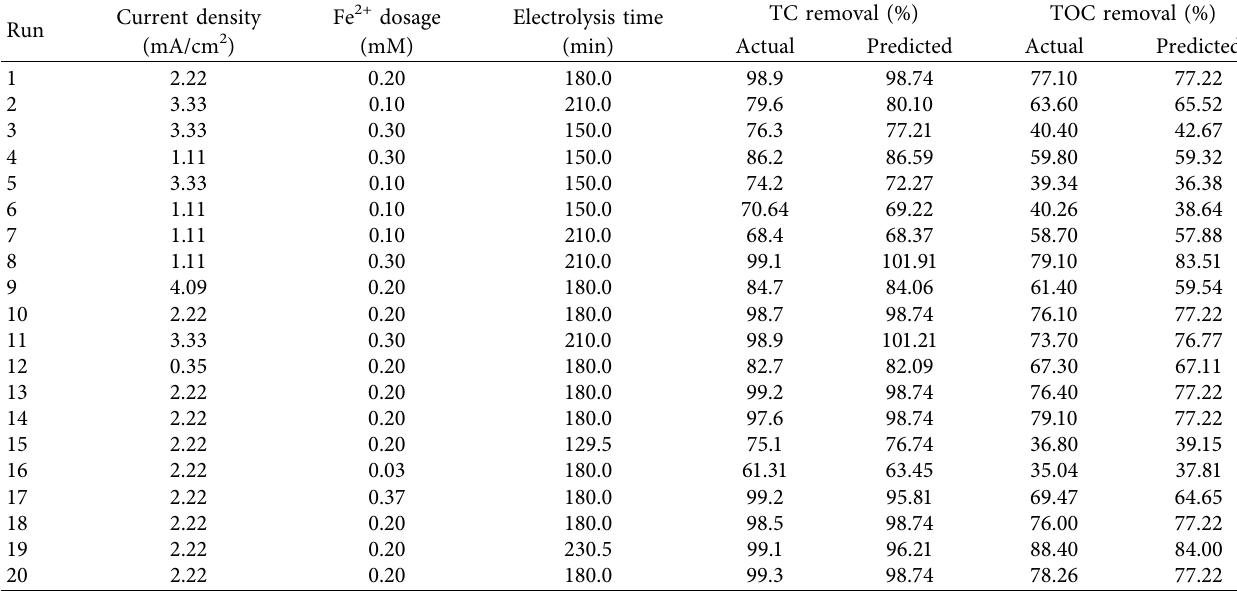
Table 2: The matrix of the CCD experiment and the corresponding experimental